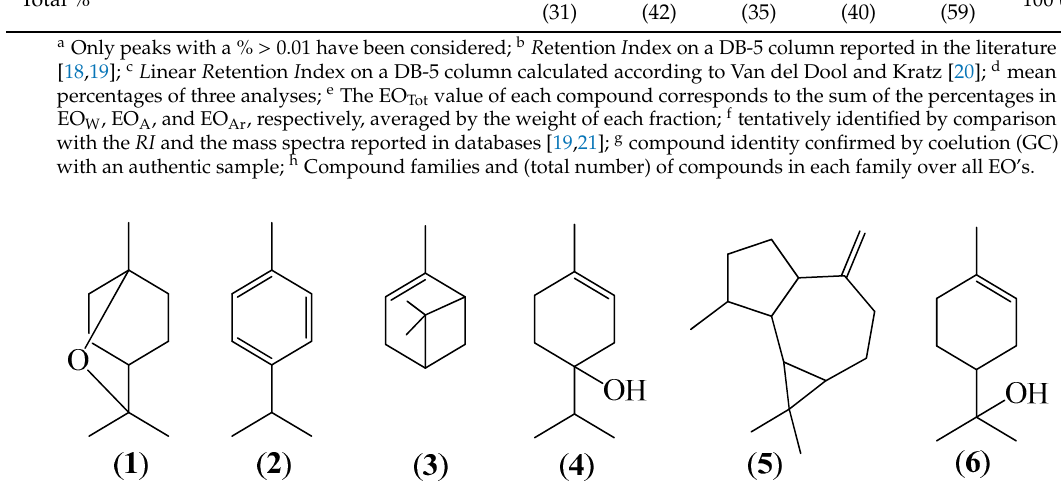
Figure 1. Structures of main components of leaf essential oil isolated from E. camaldulensis collected in the Iraqi–Kurdistan Region: 1,8-cineole ( 1 ), p -cymene ( 2 ), α -pinene ( 3 ), terpinen-4-ol ( 4 ), aromadendrene ( 5 ), and α -terpineol ( 6 ).